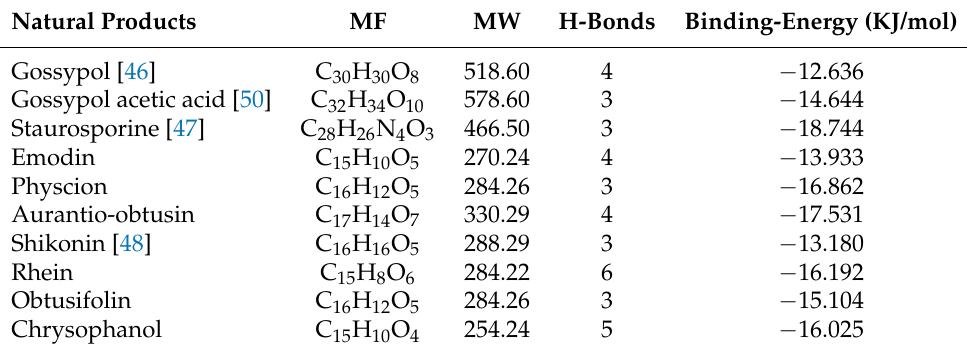
Table 8. Docking information of the top 10 natural products with the highest